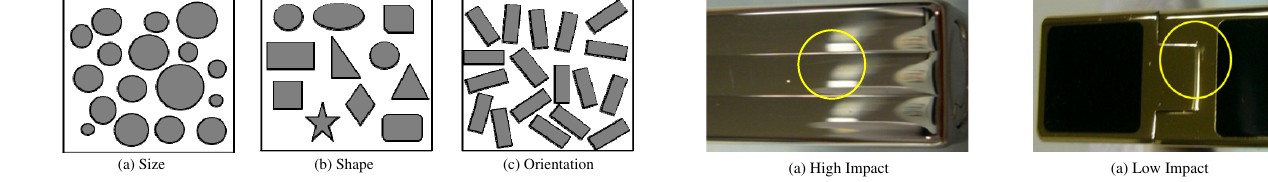
Fig. 10. Law of proximity: anomaly impact.